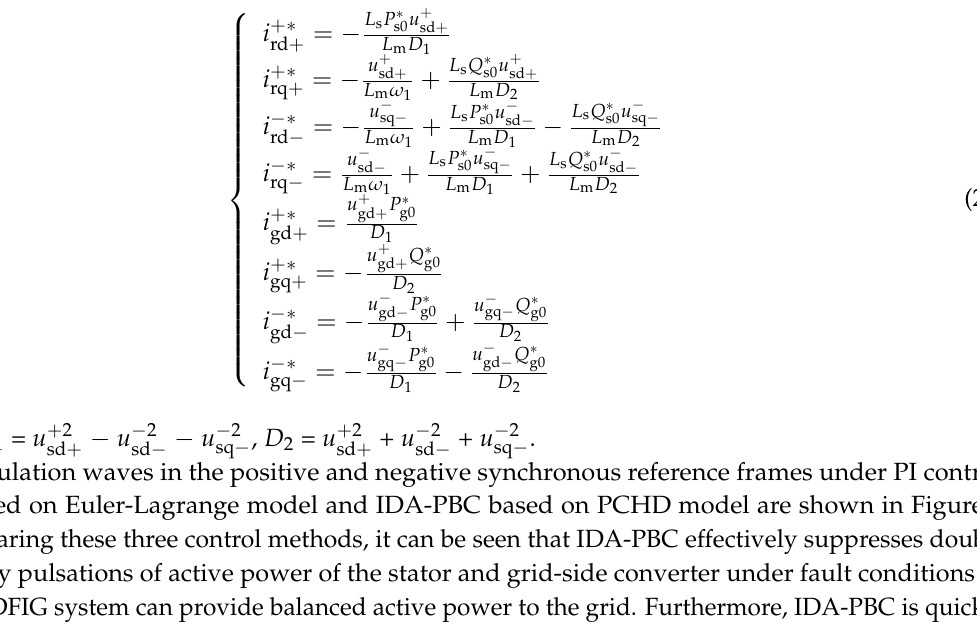
11 of 14 Figure 5. Suppressing the output current fluctuation: ( a ) Stator active current; ( b ) Grid-side converter active current; ( c ) Stator reactive current; ( d ) Grid-side converter reactive current. 4.2.2. Suppressing Output Active Power Fluctuation in a DFIG System The control target during grid voltage unbalance is to suppress double frequency pulsations of active power s P of the stator and active power g P